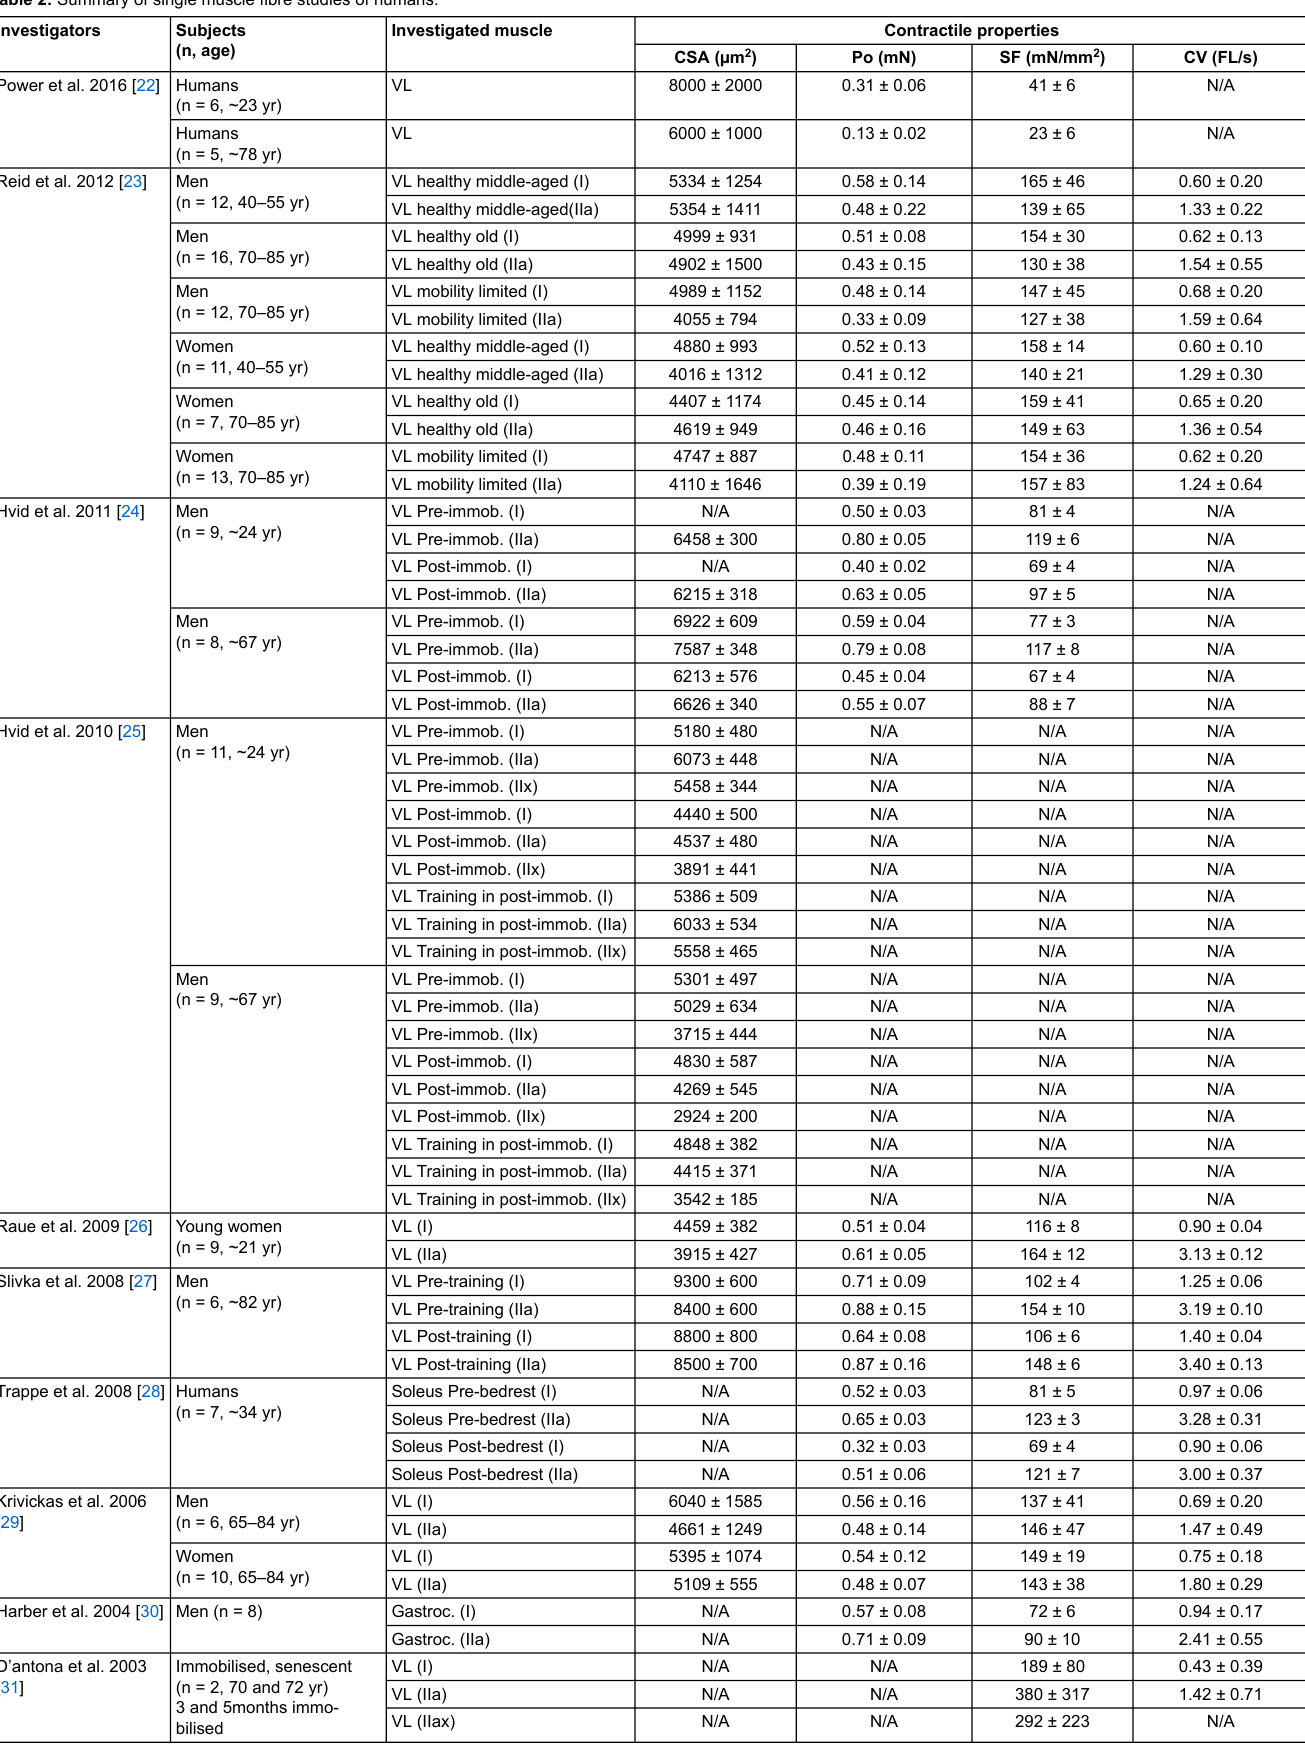
Table 2: Summary of single muscle fibre studies of